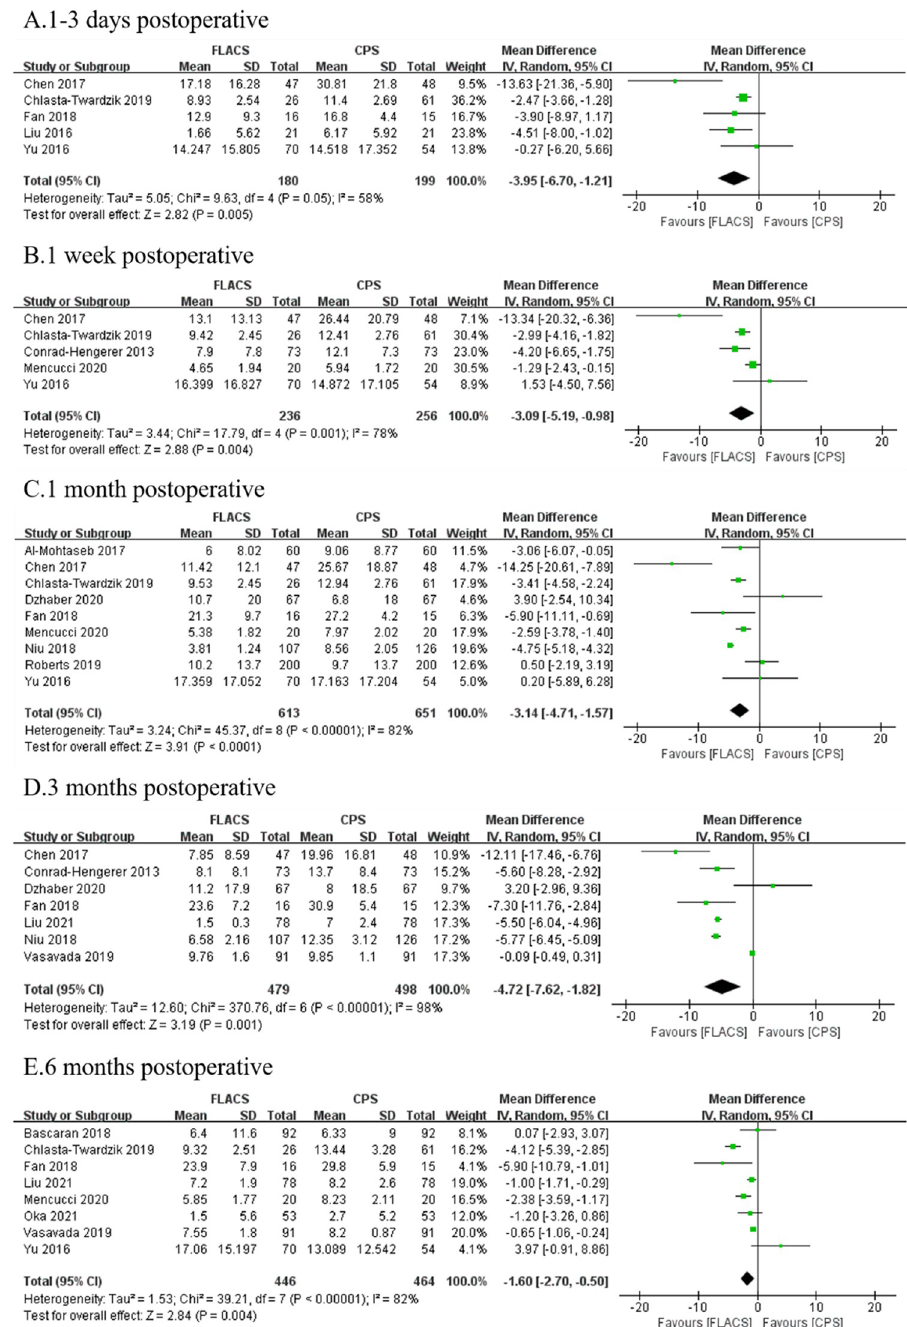
Fig 2. Forest plot of postoperative ECL% between FLACS and CPS at A. 1–3 days, B. 1 week, C. 1 month, D. 3 months, and E. 6 months. application of ultrasound energy and irrigating solution during cataract surgery [29], thereby reducing its damage to endothelial cells. As was reported by Abell [27] and Oshika [71], the effect of FLACS may be due to the lower requirement of effective phacoemulsification time (EPT), ultrasound energy, and irrigation fluid compared to CPS.